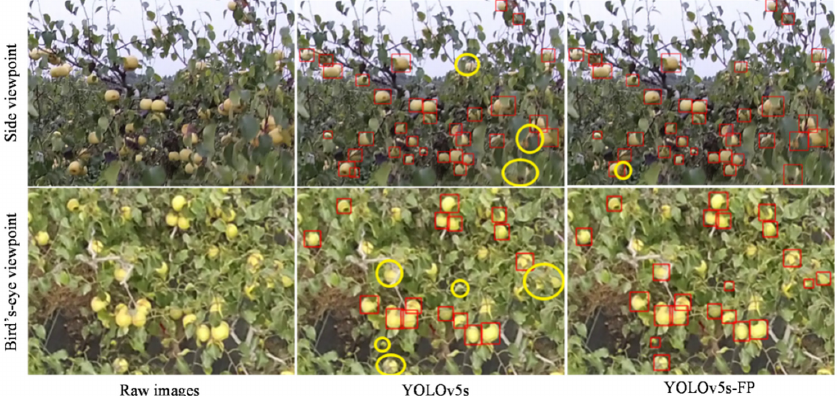
Figure 11. Comparison of pear detection results in different viewpoints of UAV, where missing pears were marked in yellow